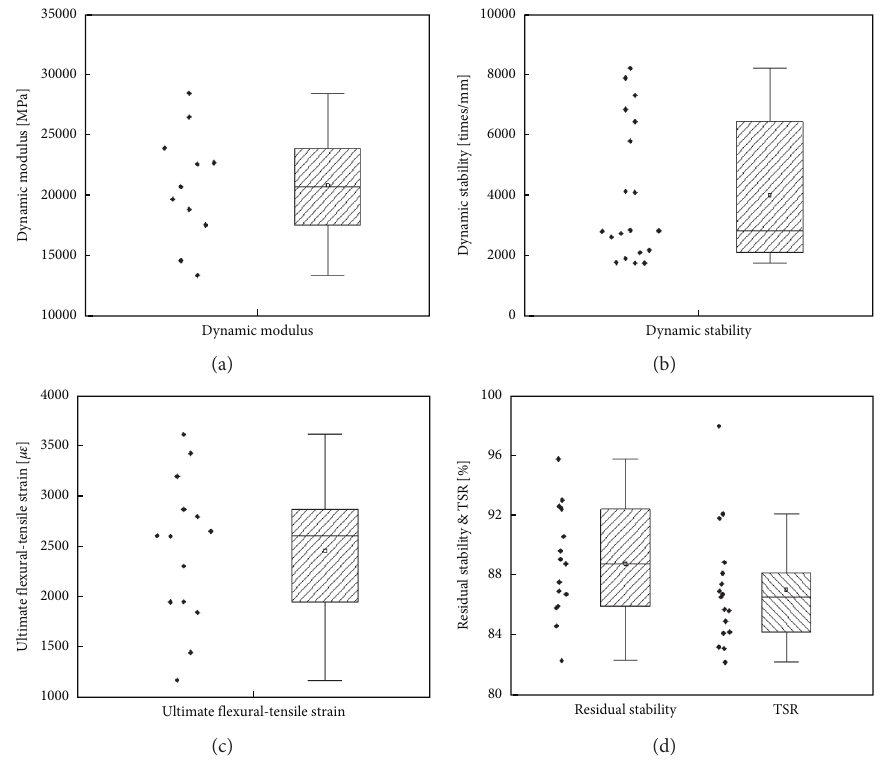
Figure 7: Performance of low-grade high modulus asphalt mixture [28, 30, 32, 36, 39, 42–54]: (a) dynamic modulus; (b) dynamic stability; (c) ultimate flexural-tensile strain; (d) residual stability and